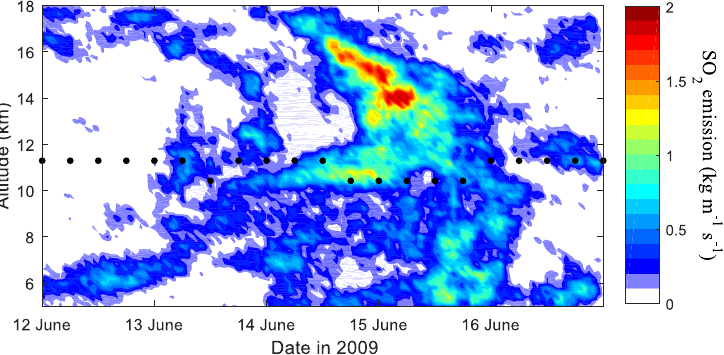
Figure 2. Sarychev SO 2 emission time series derived from AIRS measurements using a backward trajectory approach (see text for details). The emission data are binned every 1h and 0.2km. Black dots denote the height of the thermal